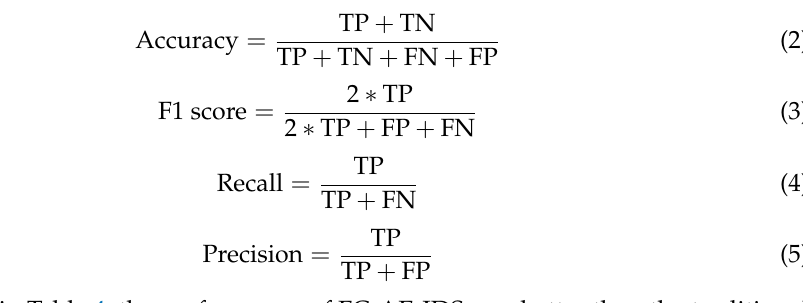
Figure 14. Results from the traditional AE-IDS: ( a ) MSE of normal traffic for dataset D1; ( b ) MSE of attack traffic for dataset D1; ( c ) MSE of normal traffic for dataset D2; ( d ) MSE of attack traffic for dataset D2; ( e ) MSE of normal traffic for dataset D3; ( f ) MSE of attack traffic for dataset